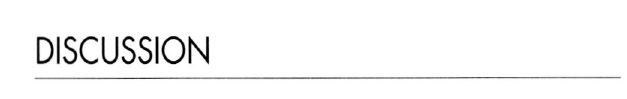
FIG 3- - Reactivity of IgG4 antibodies to ES antigen. The serum samples used included those of patients from the outbreak of trichinellosis taken place in Poland, 1991 (1-10), and serum samples received at our laboratory of patients with trichinellosis (11-15), echinococcosis (16-17), filariasis (18- 19), cysticercosis (20-22), ascariasis (23- 25), strongyloidiasis (26-28) or toxoca riasis (29-32).